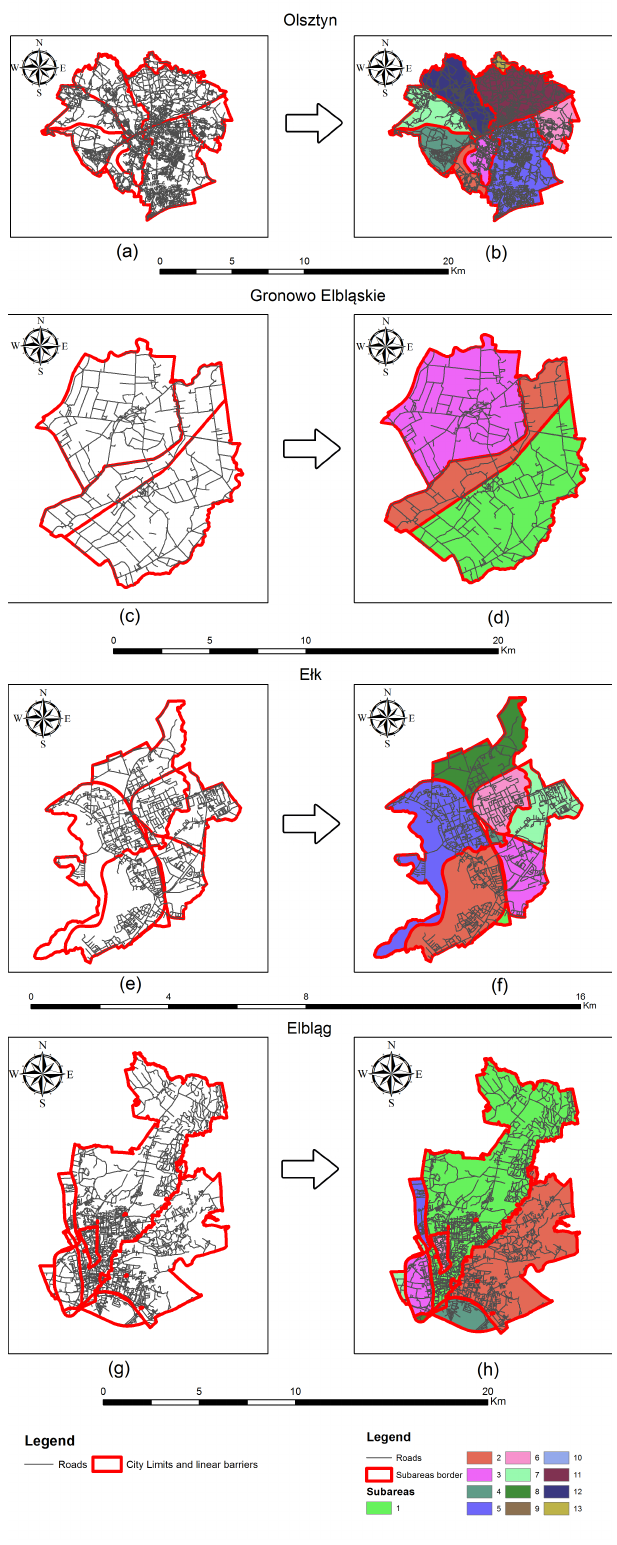
Figure 7. Division of the studied object into sub-areas. Linear barriers constitute the boundaries of sub-areas in every analyzed city: ( a , b ) Ełk; ( c , d ) Elbl ˛ag; ( e , f ) Olsztyn, ( g , h ) Gronowo Elbl